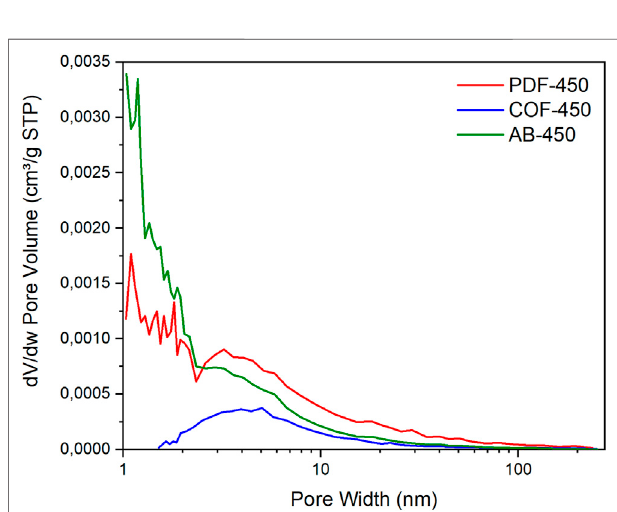
FIGURE3| Poresizedistribution oftheselectedbiochars. Thepore size distribution is calculated from the N 2 adsorption isotherms by means of the BJH